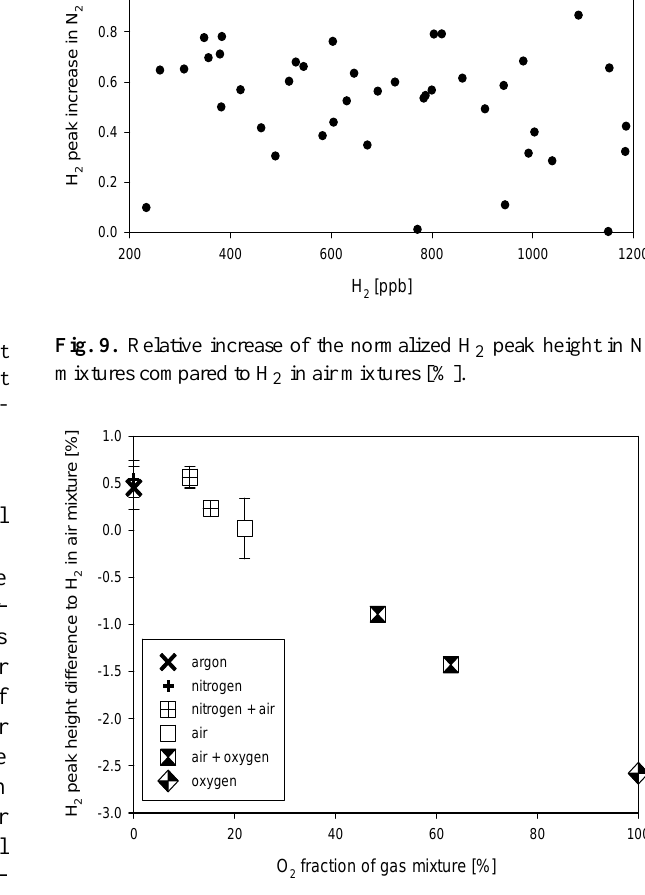
Figure 10. Dependence of the detector response on the oxygen content. Displayed are the 2 Fig. 10. Dependence of the detector response on the oxygen con- differences between the assigned H 2 concentration based on the calibration with H 2 -in-air 3 tent. Displayed are the differences between the assigned H 2 con- mixtures and the H 2 concentration as it was mixed (extended from Jordan, 2009) 4 centration based on the calibration with H 2 -in-air mixtures and the H 2 concentration as it was mixed (extended from Jordan,